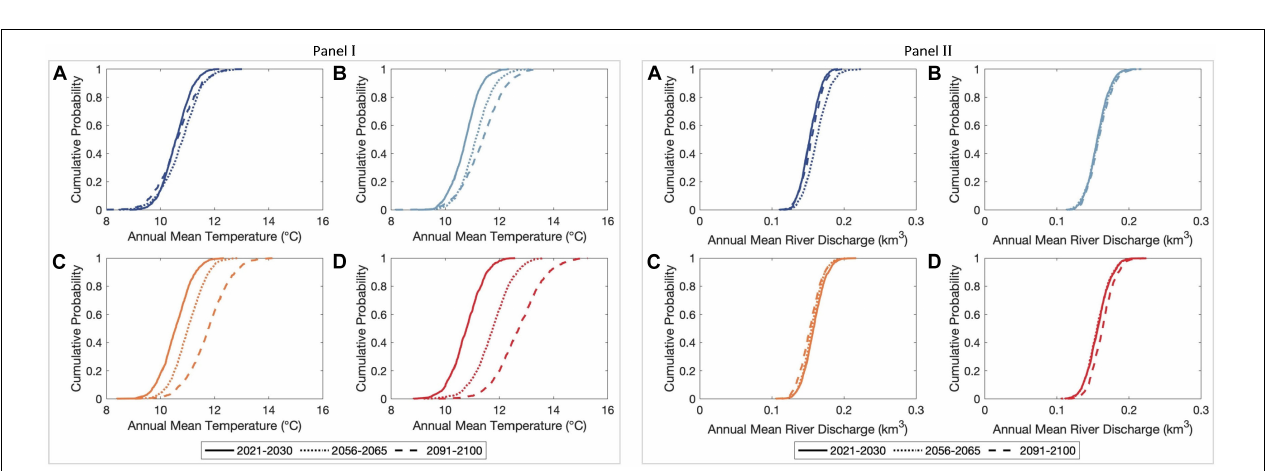
FIGURE 2 | Empirical cumulative distributions of averaged annual mean temperature (Panel I) and the annual cumulative river discharge (Panel II) in the Alsea River catchment, Oregon, the United States over the three decadal periods considered. Subplots (A) , (B) , (C) , and (D) are for the RCPs 2.6, 4.5, 6.0, and 8.5, respectively.